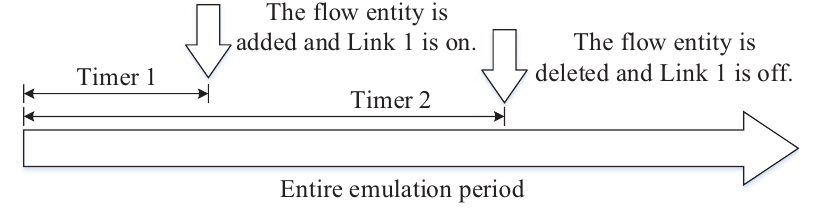
Figure 7. Realization of dynamic link